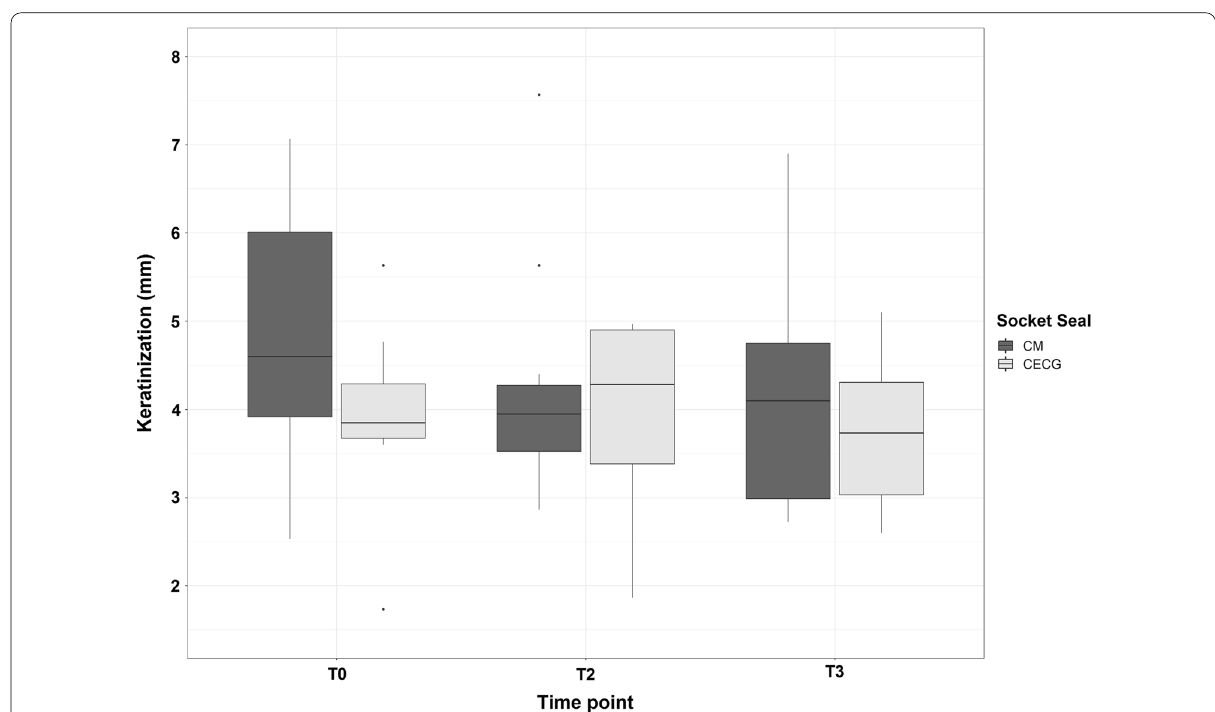
Fig. 4 Comparison of both groups on the basis of the measured widths of the keratinized gingiva at the time points T0 (prior to tooth removal), T2 (after second stage surgery) and T3 (after prosthetic restoration)